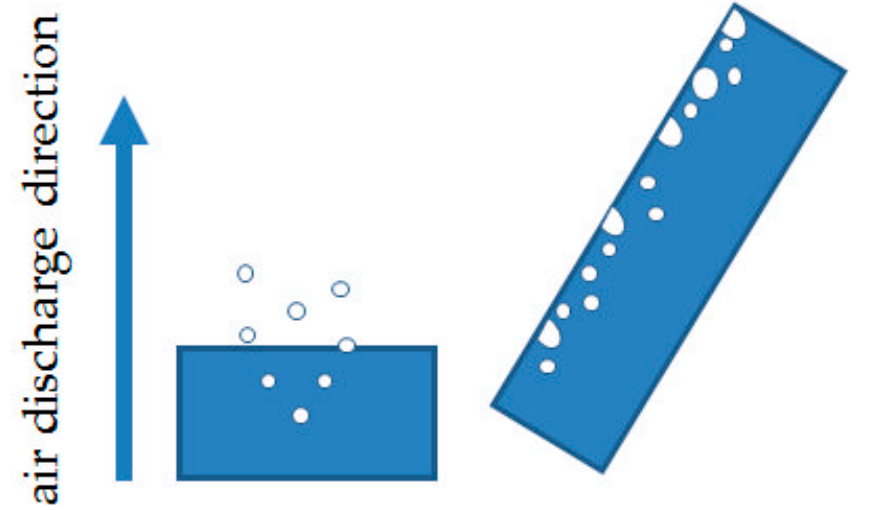
Figure 4. Degassing direction, a silicone mould on the left, and a glass mould on the right.